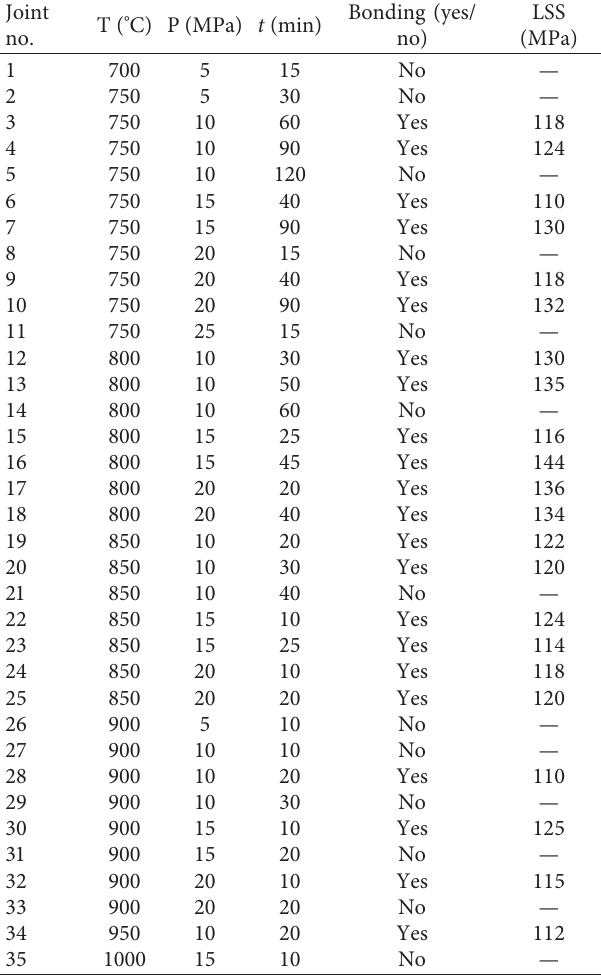
Table 3: Experimental conditions for Ti-6Al-4V/AISI304 bonds. Joint